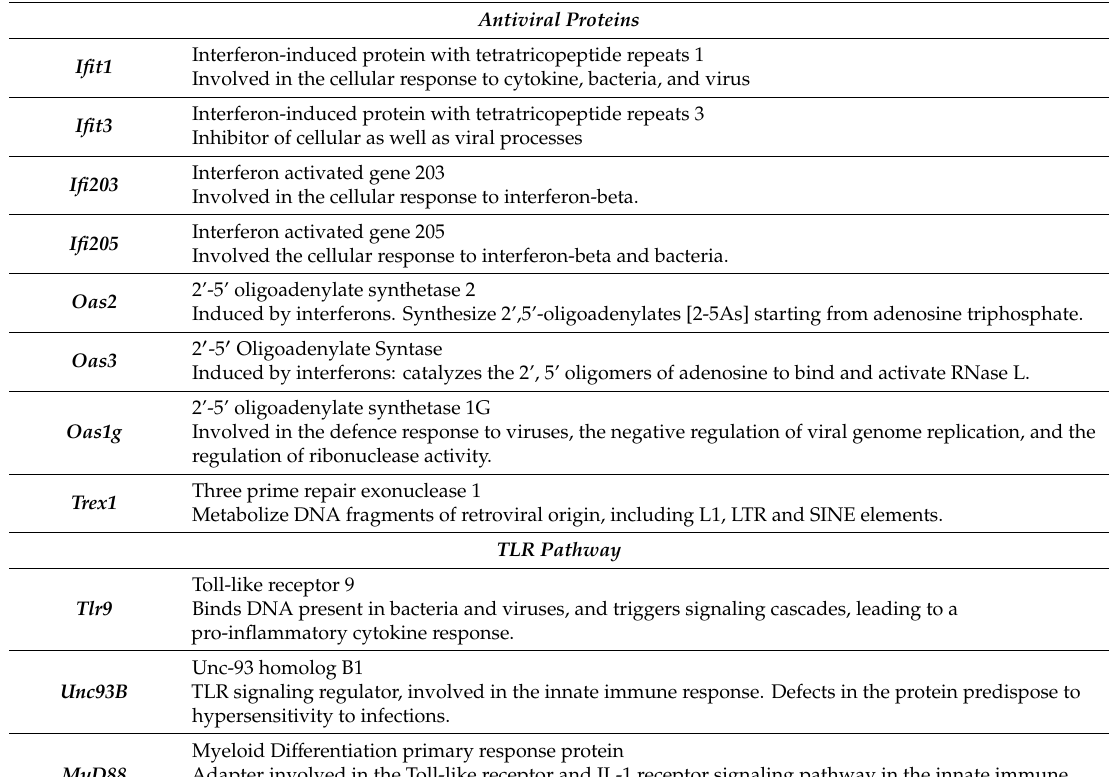
Table 2. Cont. Antiviral